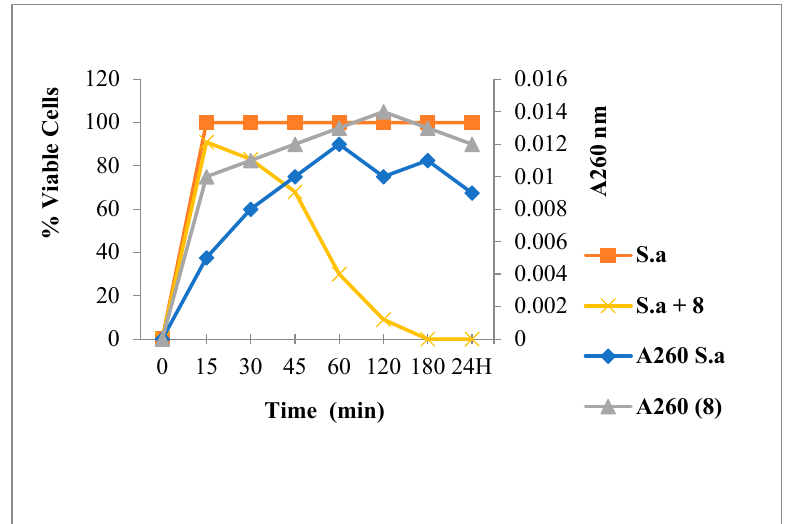
Figure 6. 260 nm absorbent material release and viability of S. aureus following Flavanone 8 treatment.